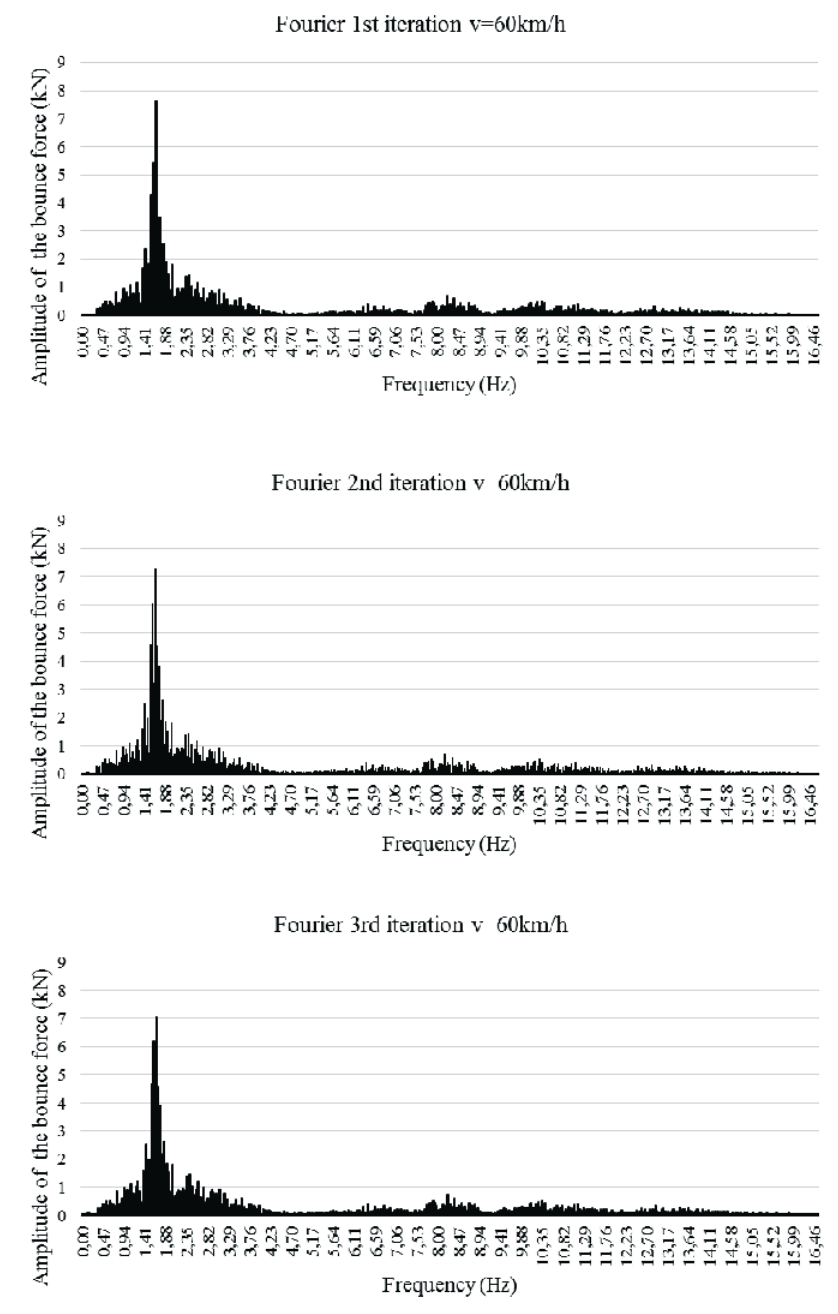
Figure 14 Fourier analysis of bounce forces F